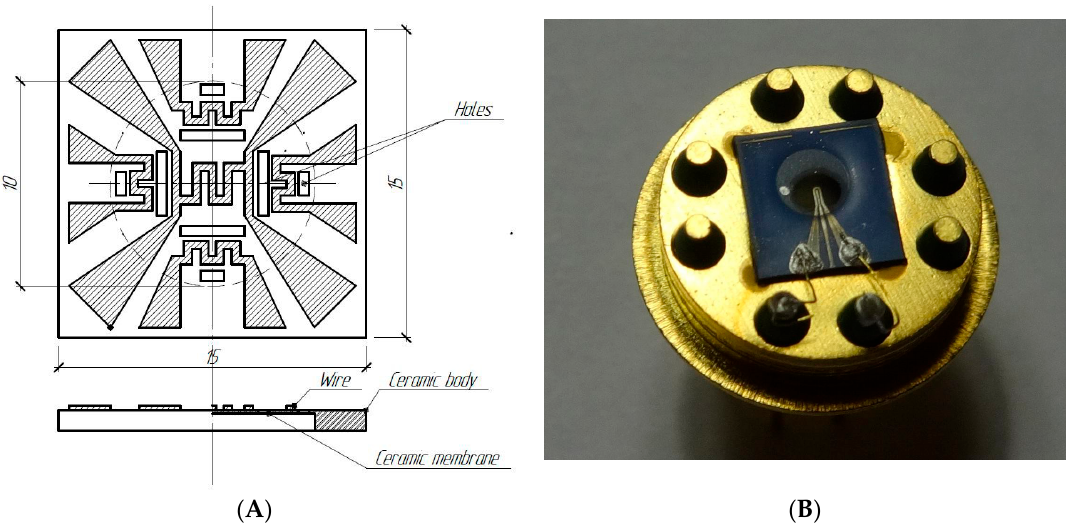
Figure 2. ( A ) Initial design of the thermoconductometric gas sensor based on ceramic MEMS. The sensor is a rigid ceramic frame made of 0.5 mm thick ceramics with hole. This hole is covered by thin ceramic film (10–30 μ m thick). On the surface of this film using aerosol jet printing platinum microheaters are formed. ( B ) Model thick film thermoconductometric sensor. Working and reference elements are marked in the